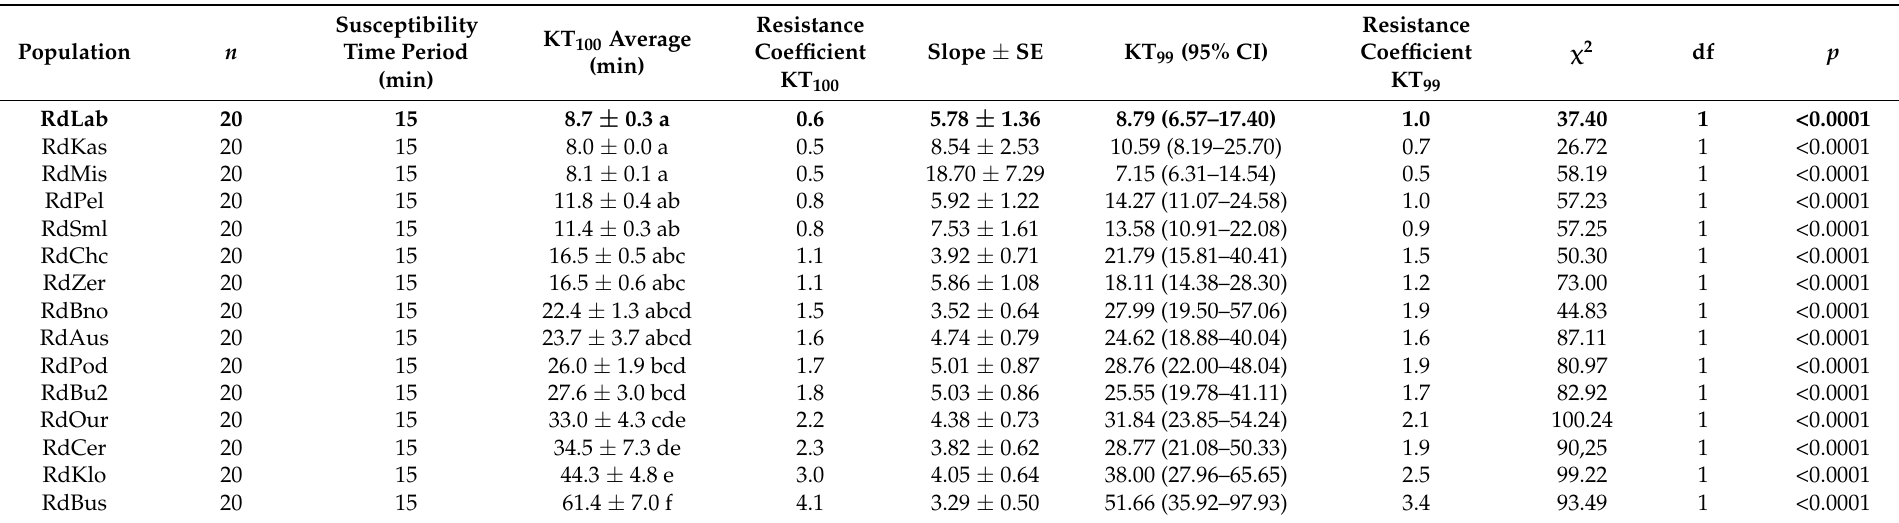
Table 3. Sensitivity or resistance level of 15 populations of Rhyzopertha dominica to phosphine based on the knockdown rapid test (PTT–Degesch, Gemany) from the Czech grain stores and the statistical comparison among the tested populations (14 field populations and 1 reference laboratory RdLab population). (Different letters (a–f) indicate statistically significant differences; n = numbers; p = p